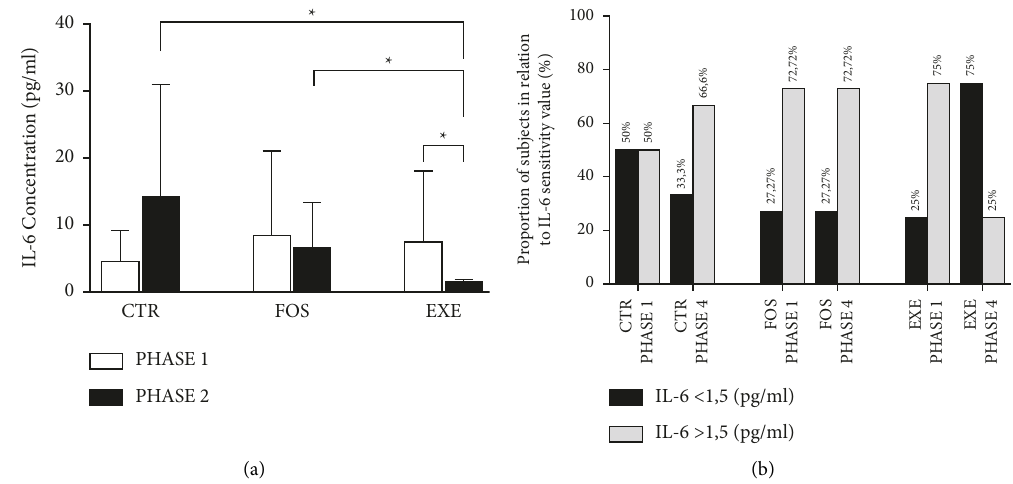
Figure 2: IL-6 results—inter- and intragroup analysis. (a) Groups distribution without IL-6 values